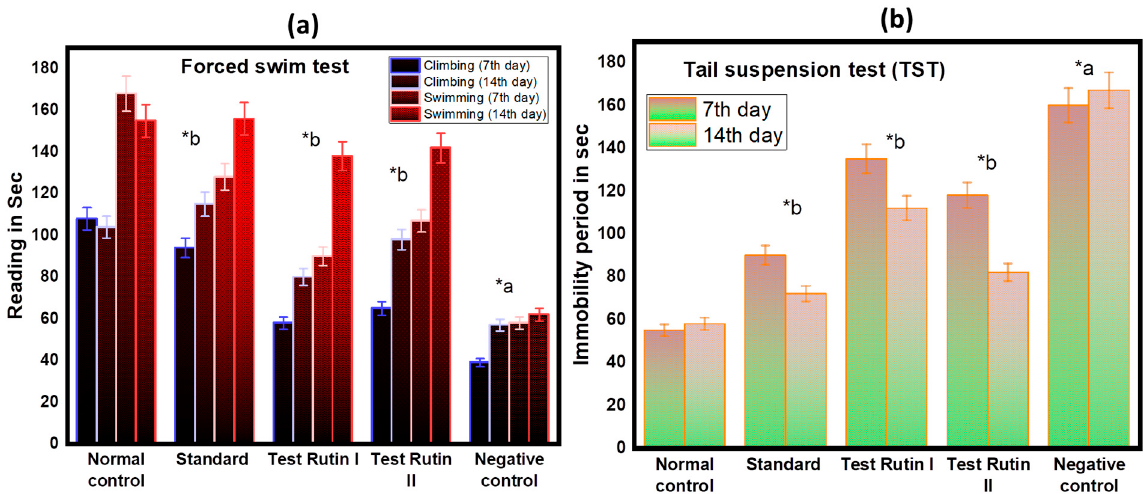
Figure 5. Effect of rutin pretreatment on antidepressant activity in rats ( a ) Forced swim test; ( b ) tail suspension test. The results are expressed as mean ± SD values ( n = 6). The significance of the difference was determined by two-way ANOVA; * p < 0.05 vs. respective controls. a = normal control vs. reserpine control; b = reserpine control vs. test.